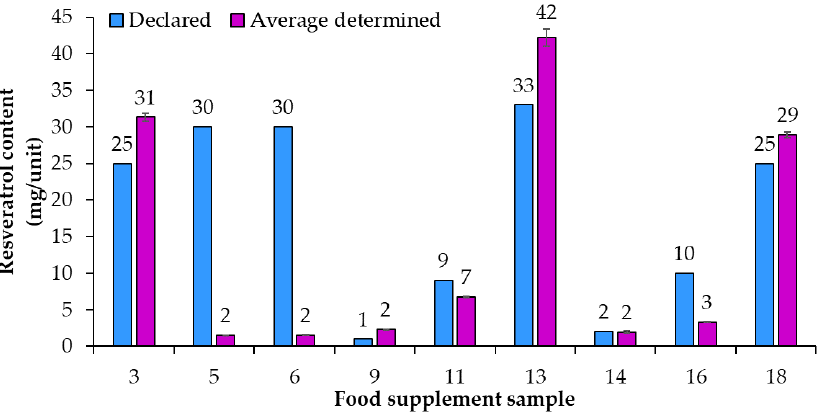
Figure 3. Comparison of declared contents vs. the average ( n = 3) determined resveratrol contents in food supplements with contents of resveratrol higher than 70 mg/unit.